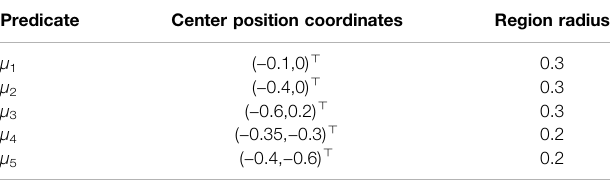
TABLE 1 | Geometric characteristics of regions of interest for an STL motion planning task. Predicate Center position